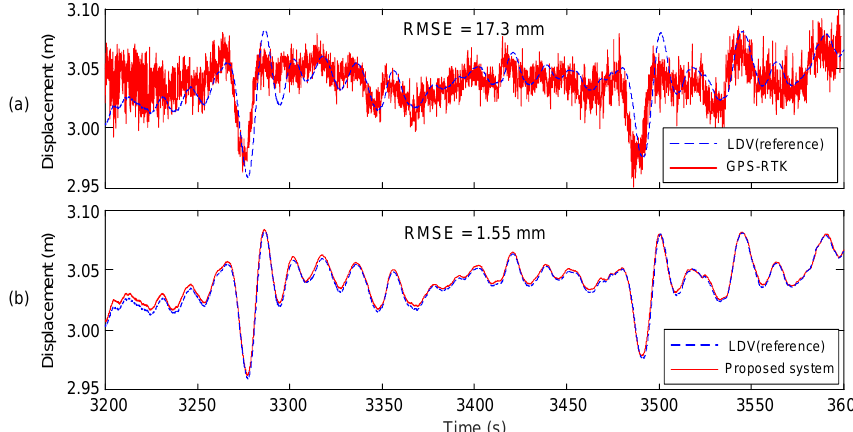
Figure 13. Comparison of ( a ) the displacement measured by RTK-GPS and; ( b ) the displacement estimated by the proposed measurement system.